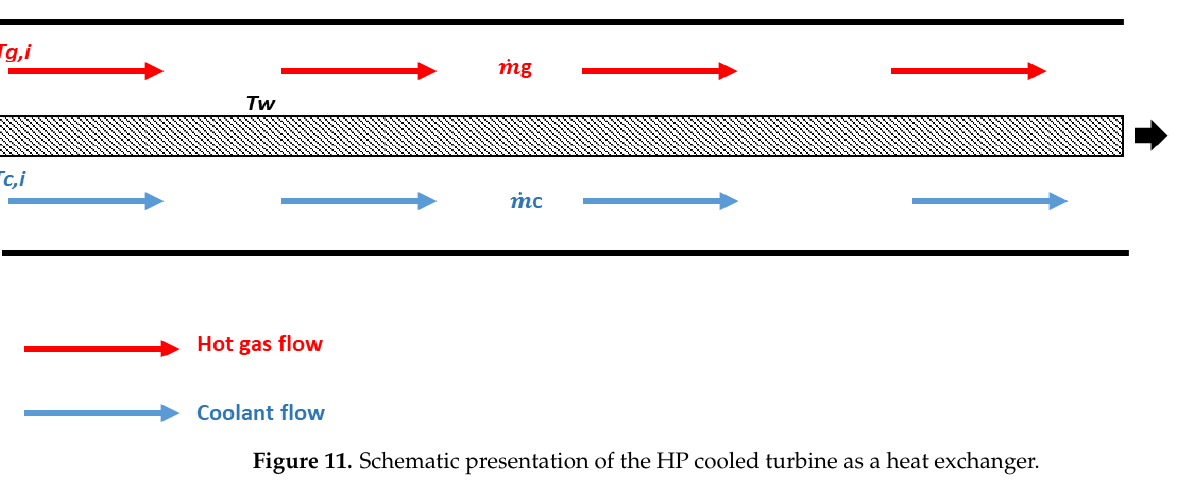
Figure 11. Schematic presentation of the HP cooled turbine as a heat exchanger.